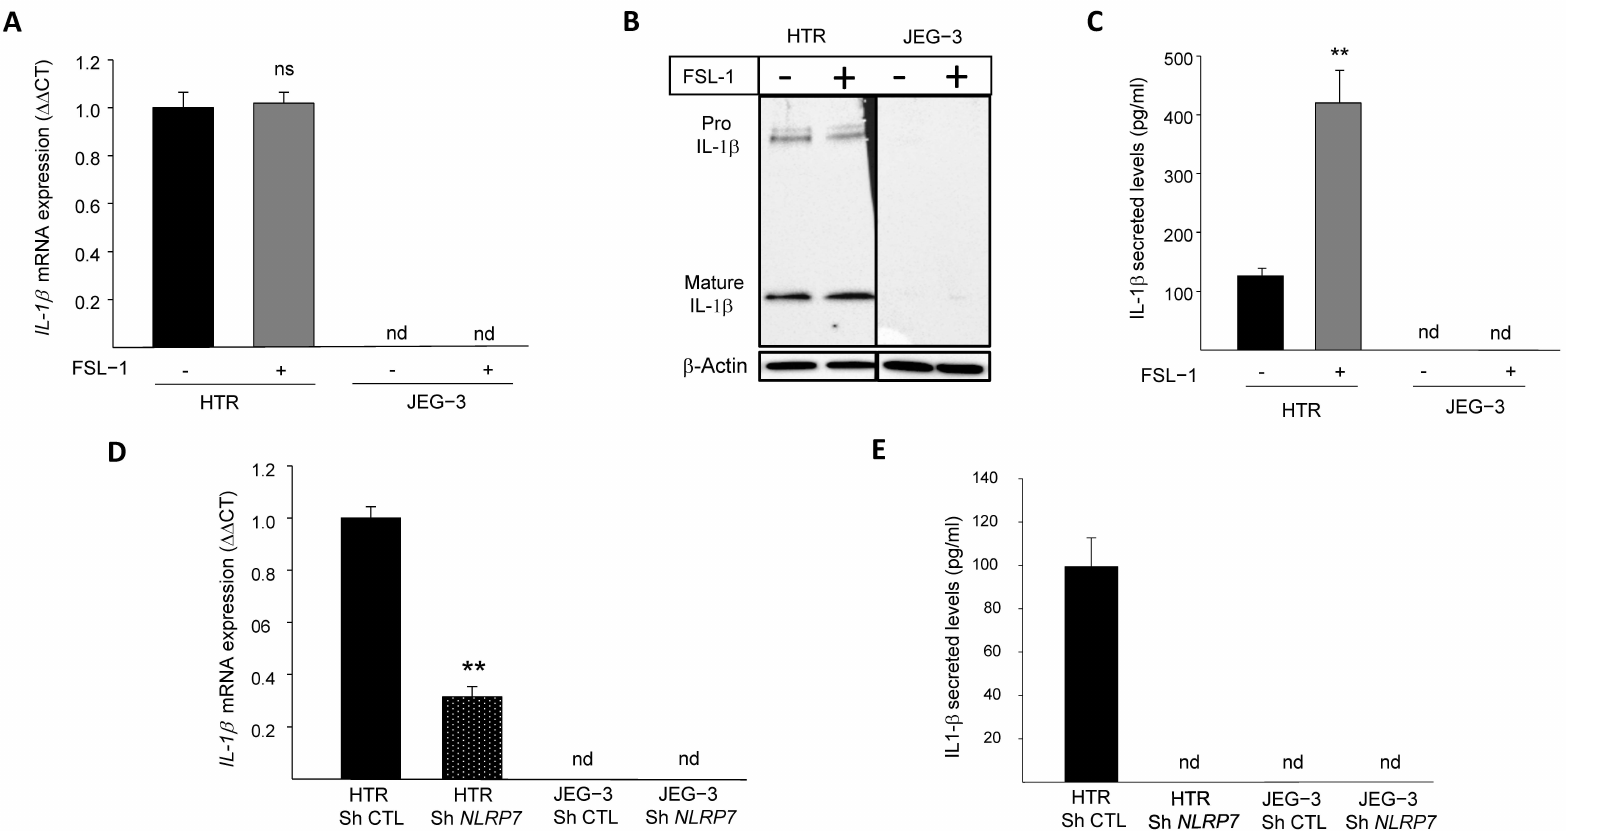
Figure 1. IL-1 β responses to FSL-1 stimulation in JEG-3 and HTR8/SVneo cells. ( A ) reports a comparison of the mRNA levels of IL-1 β expression in HTR8/SVneo and JEG-3 cells that were treated or not by FSL-1 (0.1 µ g/mL), a microbial acyl LipoPeptides agonist for NLRP7 ( n = 3); ns: non-significant, nd: not detected. ( B ) reports a comparison of Pro-IL-1 β and mature IL-1 β protein expression in JEG-3 and HTR8/SVneo cells cultured in the absence or presence of FSL-1 (0.1 µ g/mL). ( C ) reports a comparison of IL-1 β secreted levels in JEG-3 and HTR8/SVneo culture media of cells that were treated or not by FSL-1 (0.1 µ g/mL) ( n = 6); ** p < 0.01, nd: not detected. ( D ) reports a comparison of the mRNA levels of IL-1 β expression in HTR Sh CTL, HTR Sh NLRP7 , JEG-3 Sh CTL and JEG-3 Sh NLRP7 ( n = 3); ** p < 0.01, nd: not detected. ( E ) reports a comparison of IL-1 β secreted levels in culture media of HTR Sh CTL, HTR Sh NLRP7 and JEG-3 Sh CTL, JEG-3 Sh NLRP7 ( n = 3); nd: not